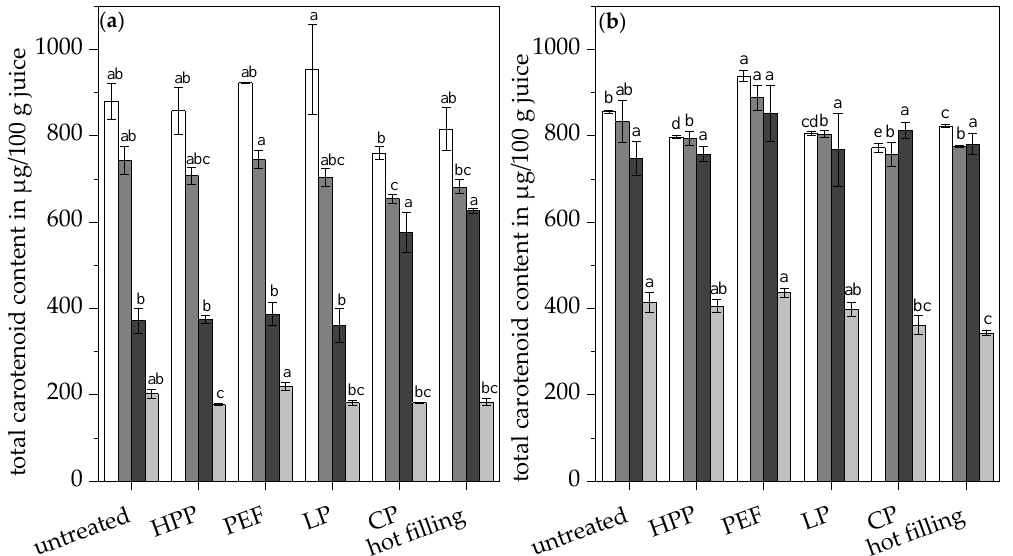
Figure 3. Total carotenoid concentration in the juices ( (cid:3) ) and in the total fraction ( (cid:4) ), soluble fraction ( (cid:4) ), and micellar fraction ( (cid:4) ) of the untreated and pasteurized juices without ( a ) and with ( b ) ultrasonication. Different letters indicate significant differences ( p ≤ 0.05). Values are means ± standard deviation ( n = 3).